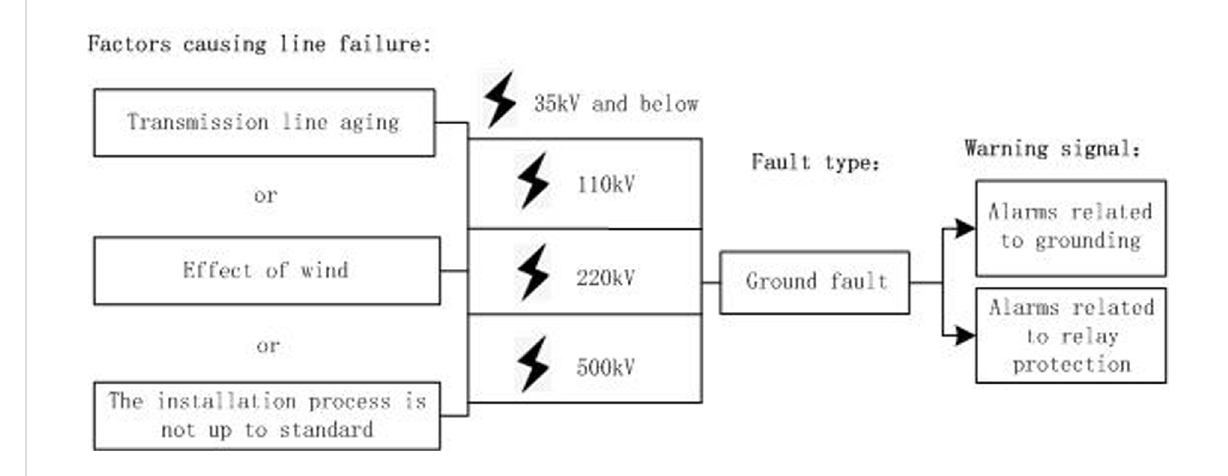
FIGURE 4 Mechanism of generating alarm signals.